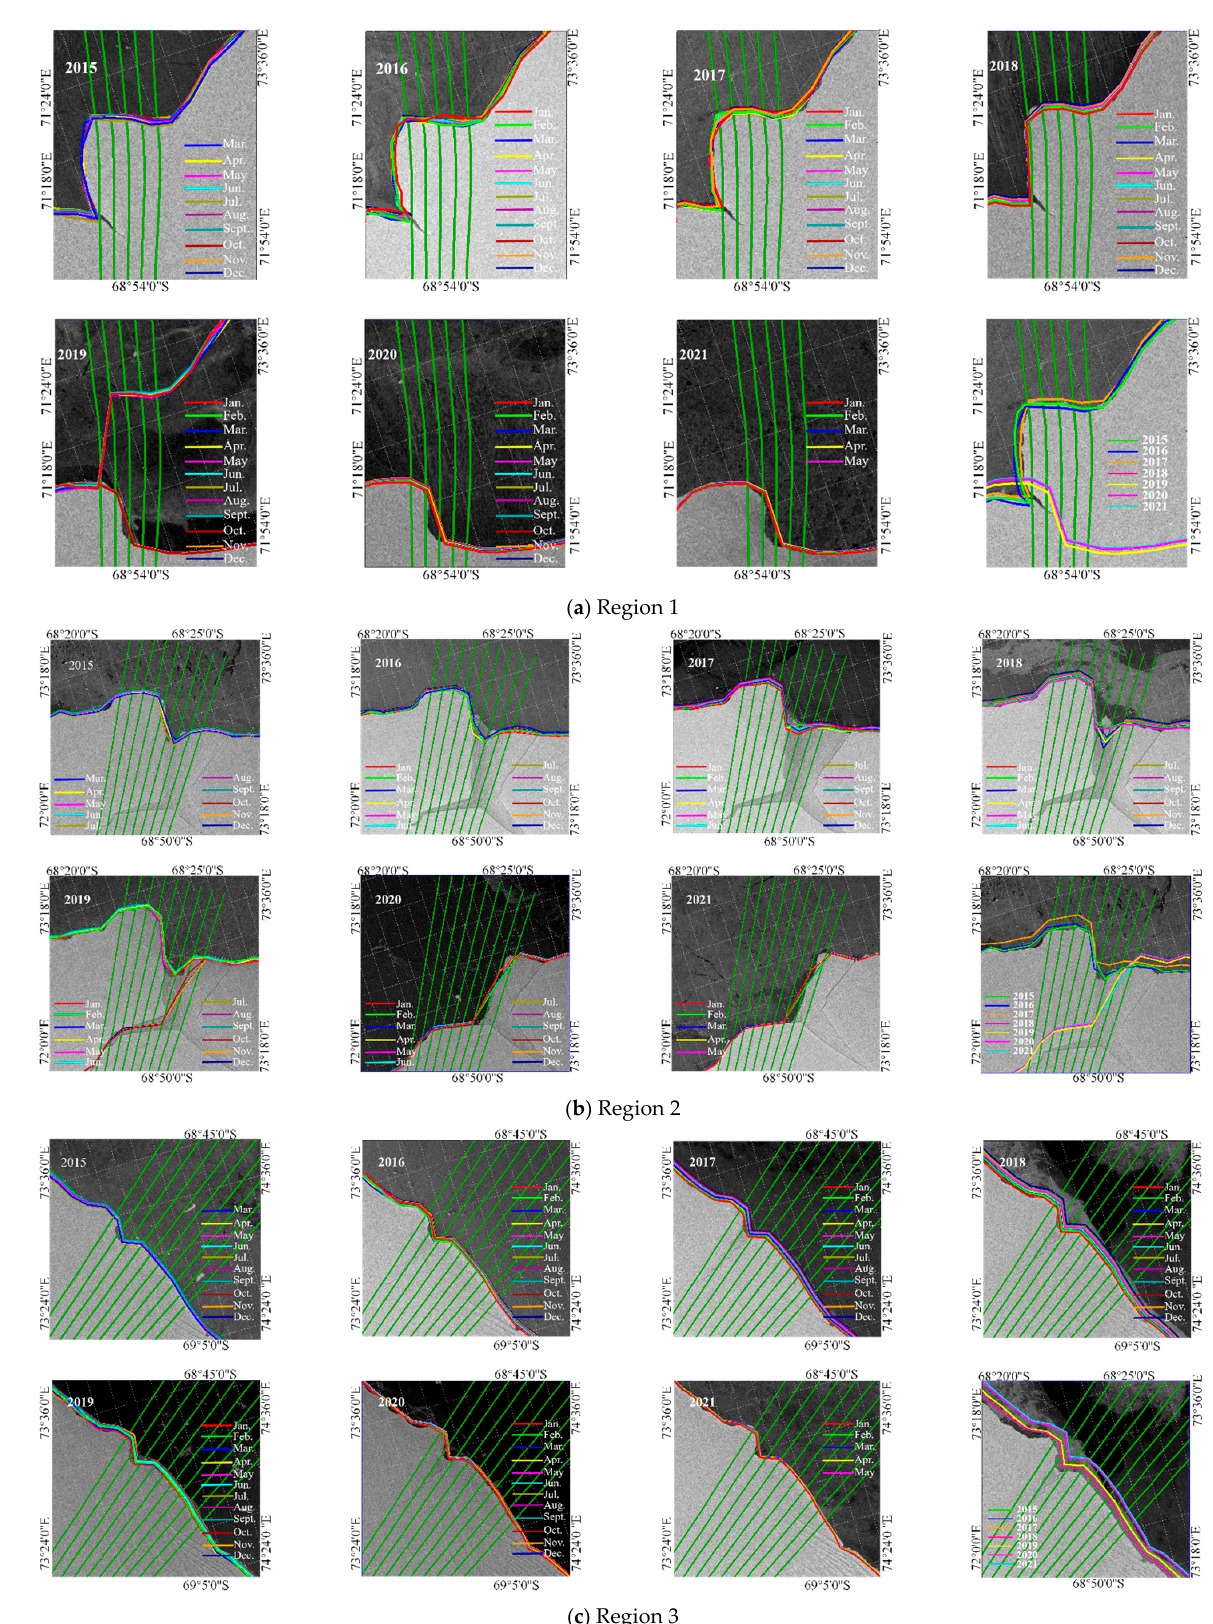
Figure 8. The result of frontal line in the three regions from 2015 to 2021. All the background image is acquired in March of each year except for 2019 in September. For the last panel, the background image were acquired in March 2015 for Region 1, 2, and 3. ( a ) Region 1; ( b ) Region 2; ( c ) Region